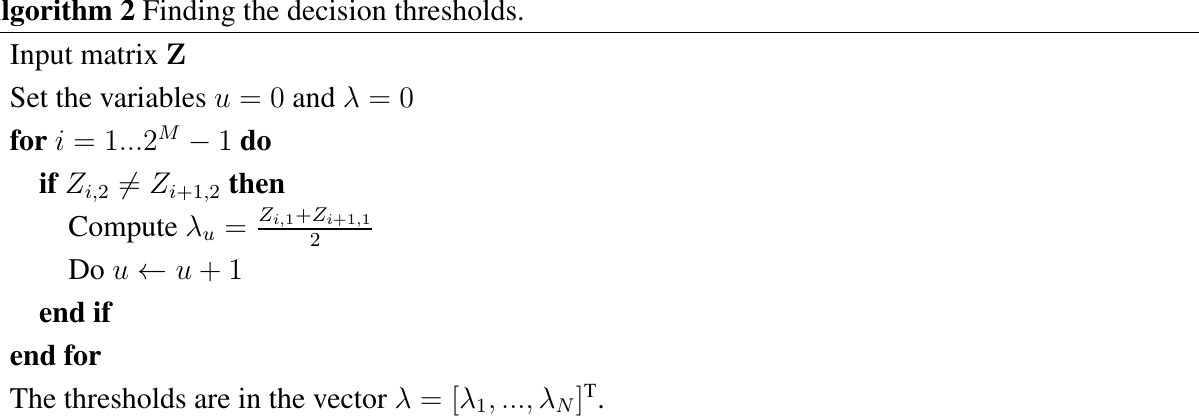
Algorithm 2 Finding the decision